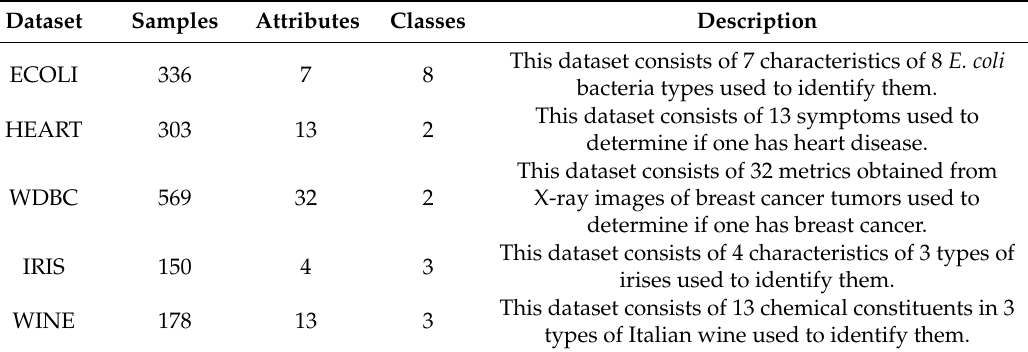
Table 1. Summarized descriptions of the experimental